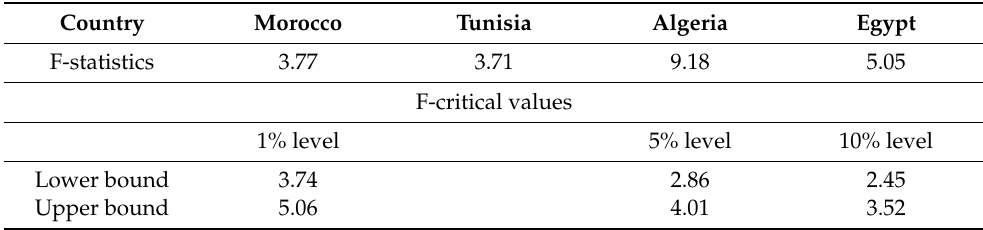
Table 4. Bounds test